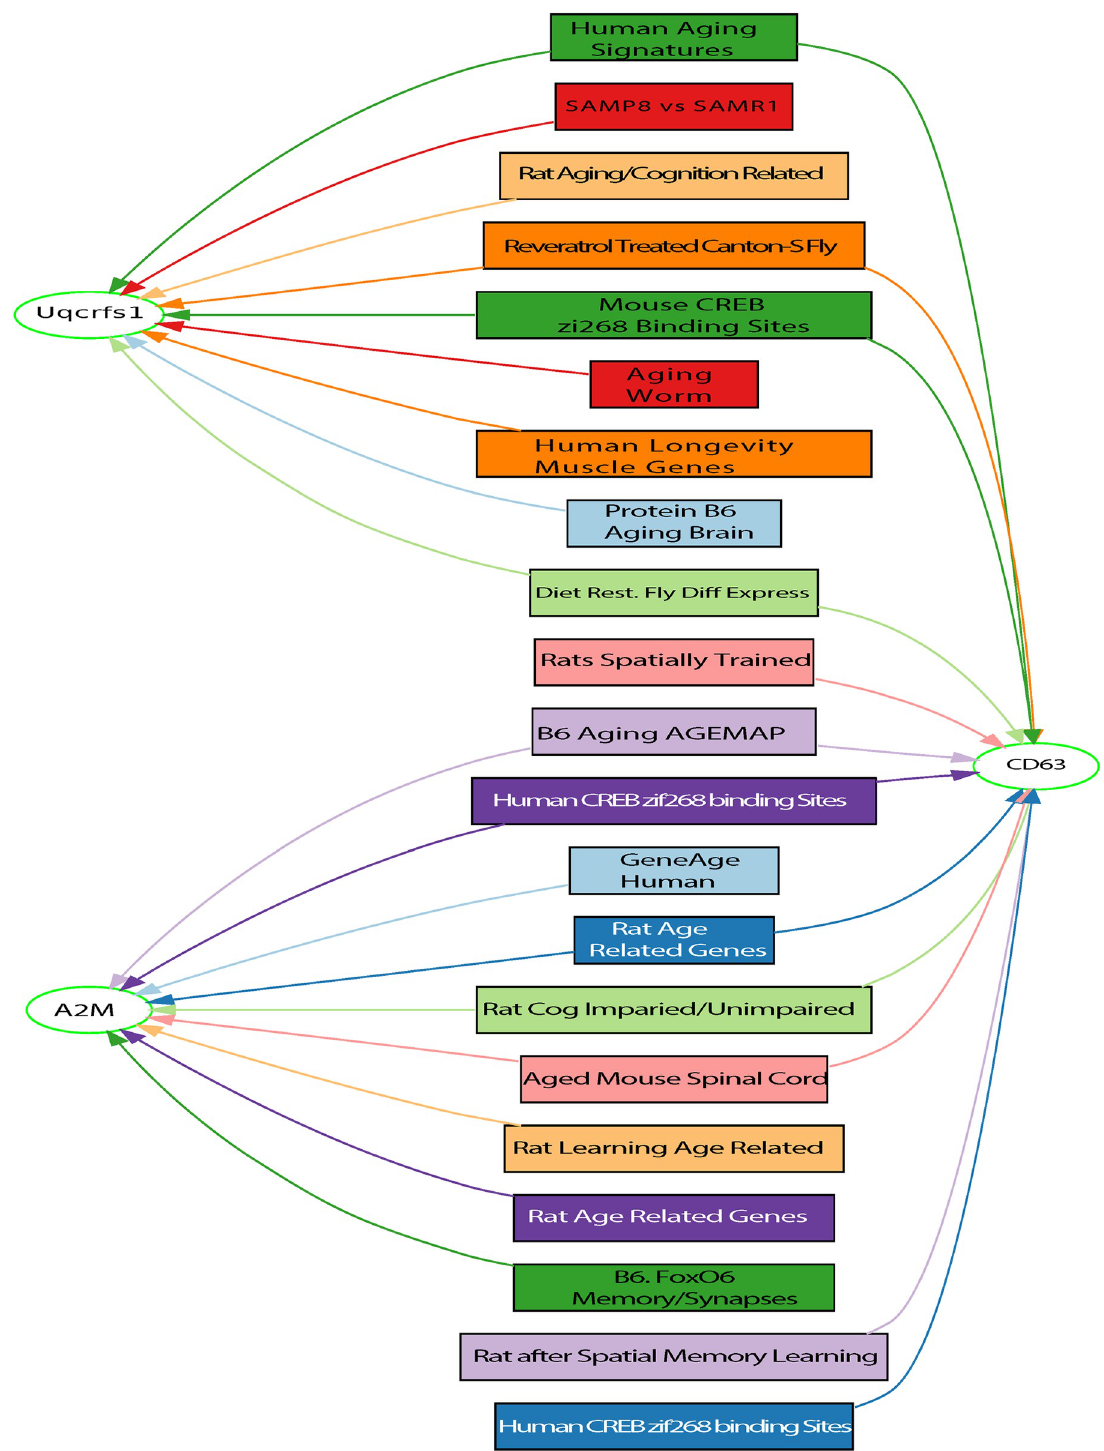
Fig 3. GeneSet graph of the most highly connected genes from 73 gene sets from six different species. The GeneSet Graph Tool presents a partitioned display of genes and GeneSets. Genes are represented by elliptical nodes, and GeneSets are represented by boxes. The least-connected genes are displayed on the left, followed by the GeneSets, then the more-connected genes in increasing order to the right. Genes and GeneSets are connected by colored lines to show what genes are in which GeneSets.